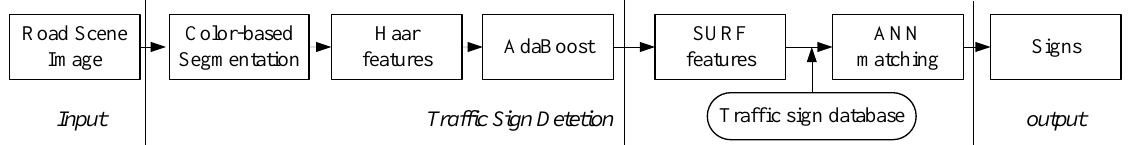
Figure 8. Traffic Signs Classes.